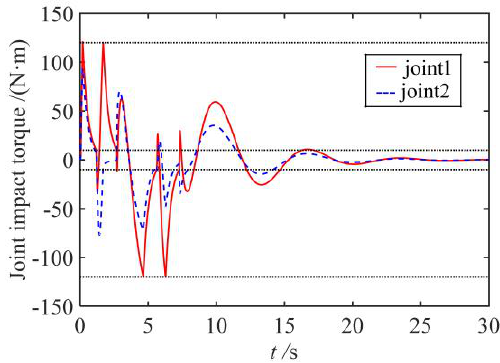
C1 C1 F =120 N m, F =10 N m   ). Figure 11. Joint impact torque (F = 120 N · m, F C1 O1 C1